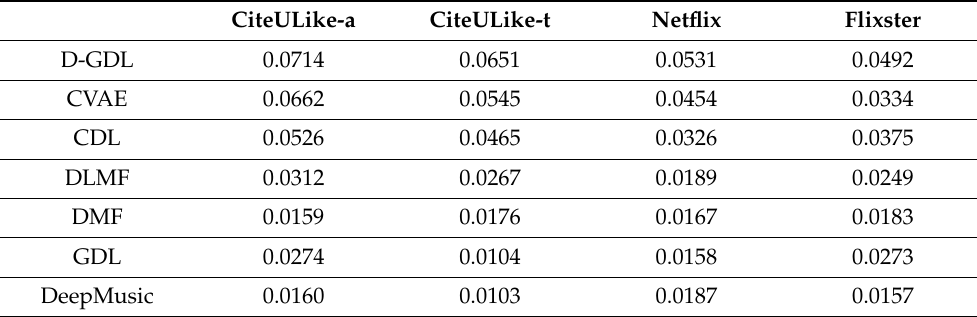
Table 4. mAP Results for the Four